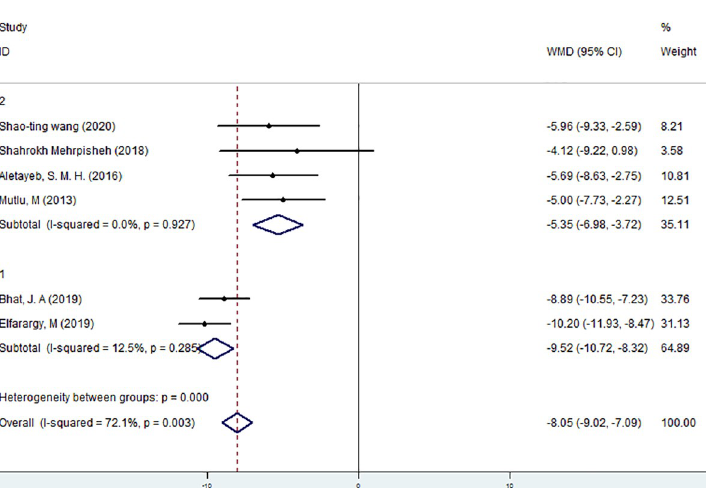
Fig 4. Meta-analysis of the relationship between vitamin D and neonatal hyperbilirubinemia in different subgroups.